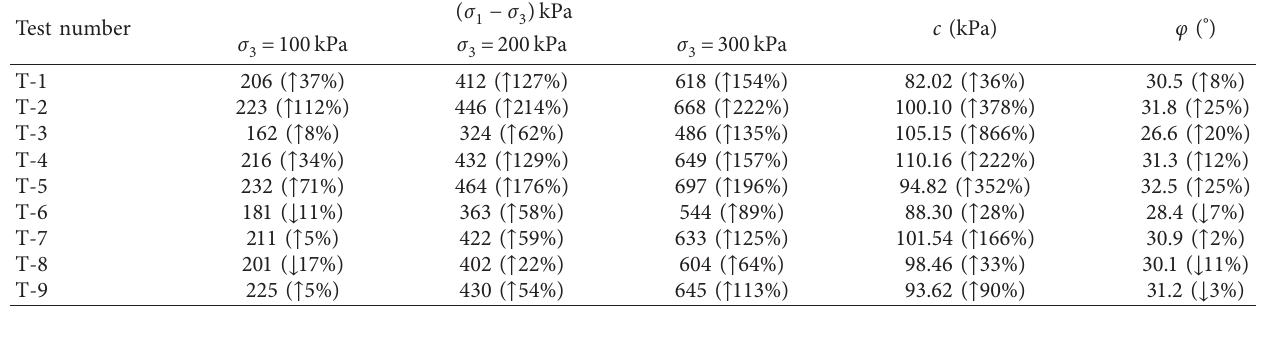
Table 3: Shear strength index of reinforced loess.